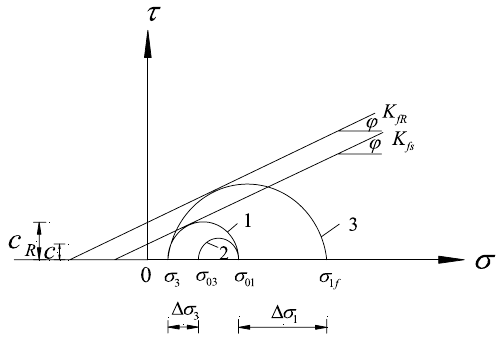
Figure 4. Mohr’s envelope of rock